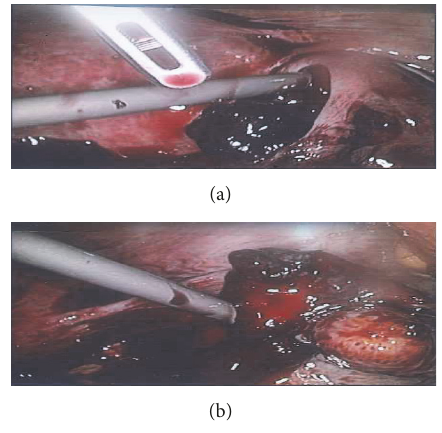
Figure 1: Ruptured right ectopic